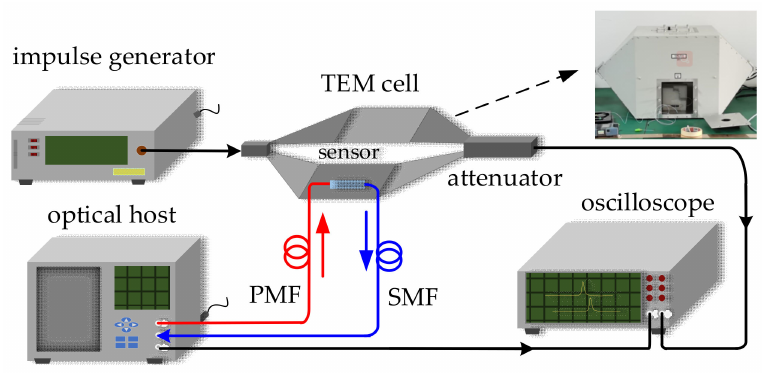
Figure 11. Schematic of time-domain response measurement setup.